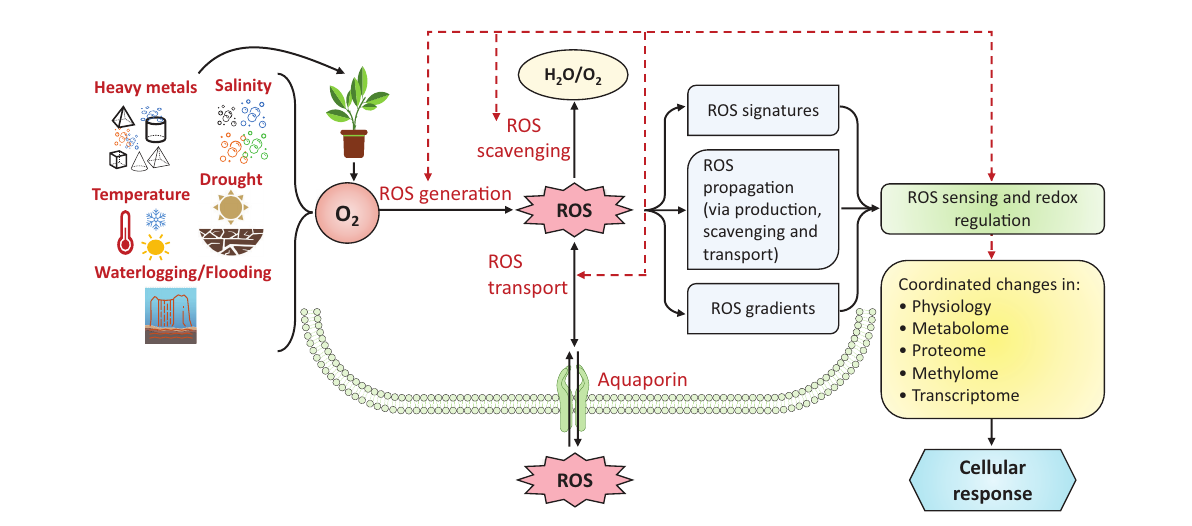
FIGURE2 Management of ROS metabolism and signaling in plants under stress conditions. Cellular ROS accumulation is controlled by three main methods—(1) ROS generation, (2) ROS scavenging, and (3) ROS transport—which maintain ROS concentrations and produce various ROS signatures and gradients that act as signals in various abiotic factor-response signal transduction pathways. These redox regulations lead to coordinated changes in the plant’s physiology, metabolome, proteome, methylome, and transcriptome. Dashed arrows show that ROS generation, scavenging, and transport can be controlled by the ‘redox state’ of plant cells under stress. Figure based on the concept of Mittler et al. (2004, 2022). For more information on ROS metabolism and signaling, readers are referred to Mittler et al. (2022). ROS, reactive oxygen species; O 2 , oxygen; H 2 O,